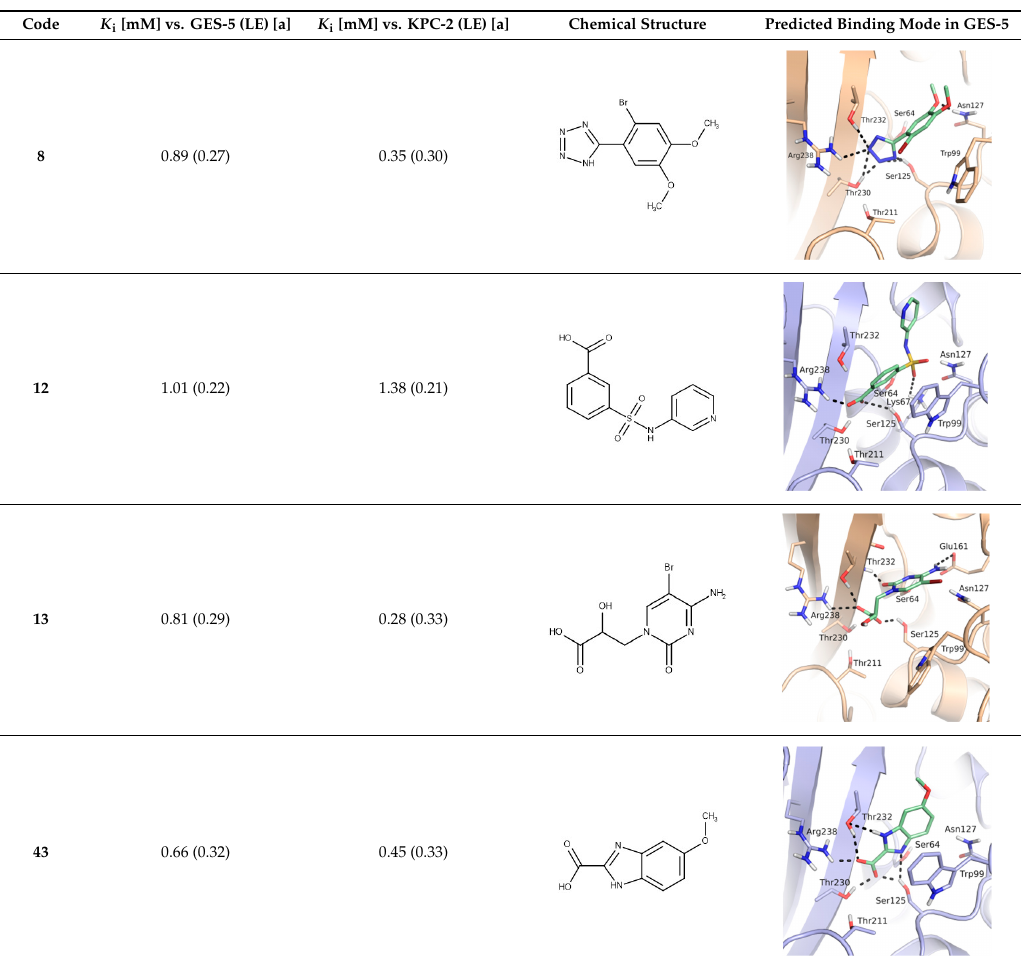
Table 1. Inhibition constants, LEs and predicted binding modes of the most potent compounds. The structure with Trp99 in the conformation found in GES-5 is colored in beige; the structure with KPC-2 conformation of Trp99 in blue. The compounds are colored in green; hydrogen bond interactions are indicated as black dots.